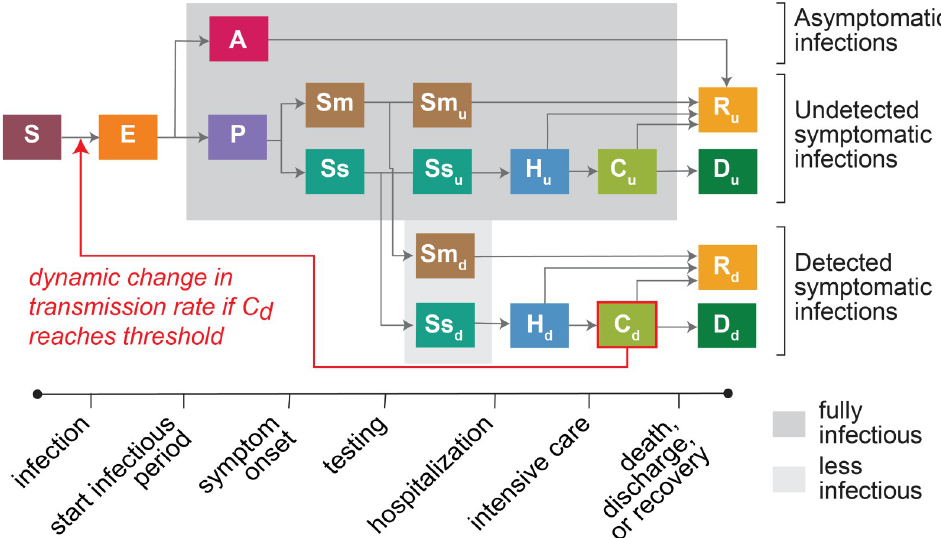
Fig 2. Structure of SARS-CoV-2 transmission and COVID-19 disease progression model. The compartments include Susceptible (S), Exposed (E), Asymptomatic (A), Pre-symptomatic (P), Mild symptomatic (Sm), Severe symptomatic (Ss), Hospitalized (H), Critical—intensive care (C), Deaths (D), Recovered (R). The subscripts d and u refer to infections detected and undetected by diagnostic testing, respectively. The red arrow shows the feedback loop from ICU COVID-19 occupancy within the C d compartment (detected SARS-CoV-2 infections requiring intensive care) affecting the transmission rate that defines the transition from S to E.